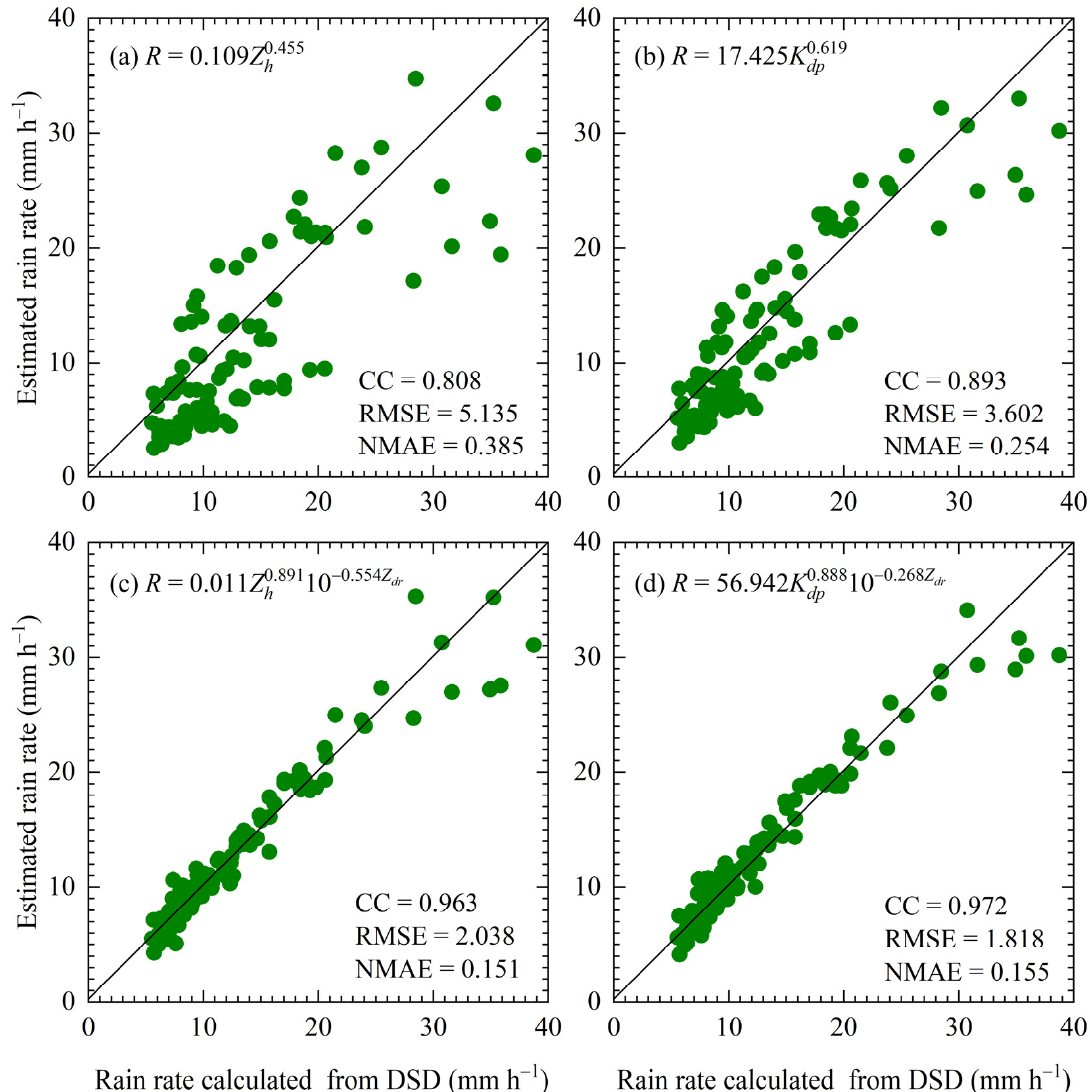
Figure 10 . Same as Figure 9 but for convective rainfall. Figure 10. Same as Figure 9 but for convective